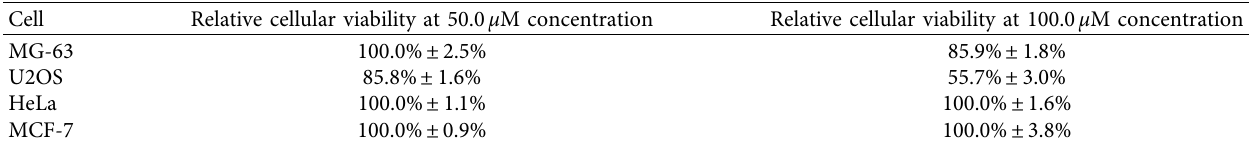
Figure 1: The molecular structure, HOMO, and LUMO of the ligand and DBPP by DFT Table 1: Relative cellular viability of DBPP for 24h a .